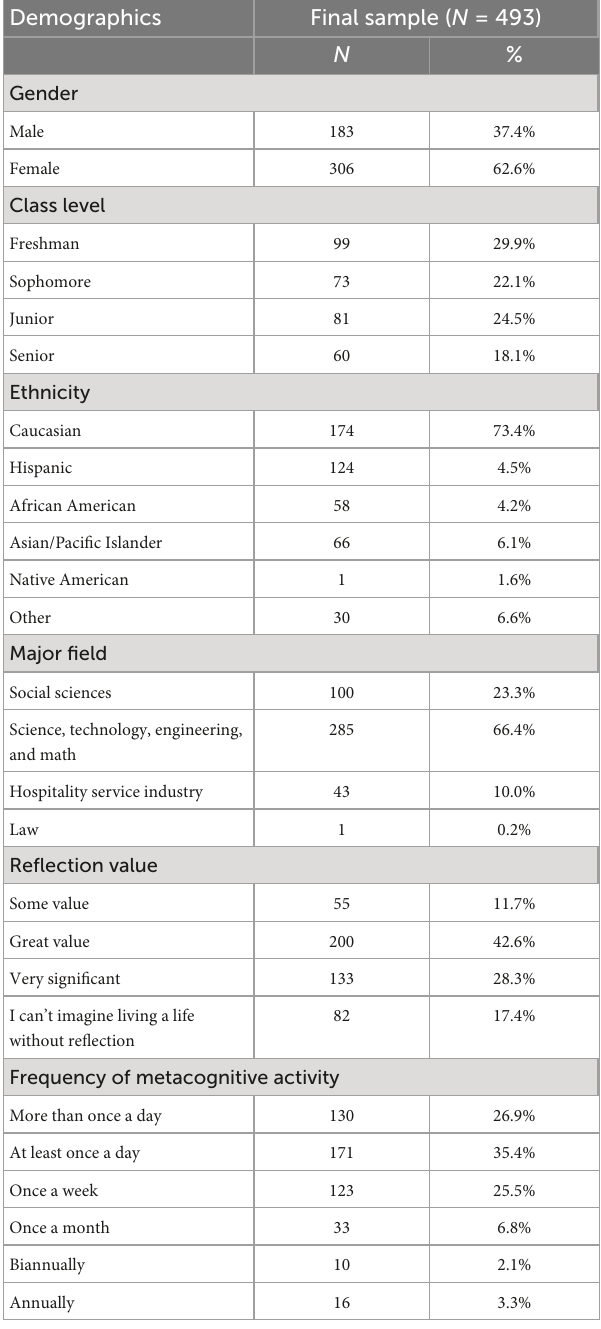
TABLE 1 Participant demographic and reflection